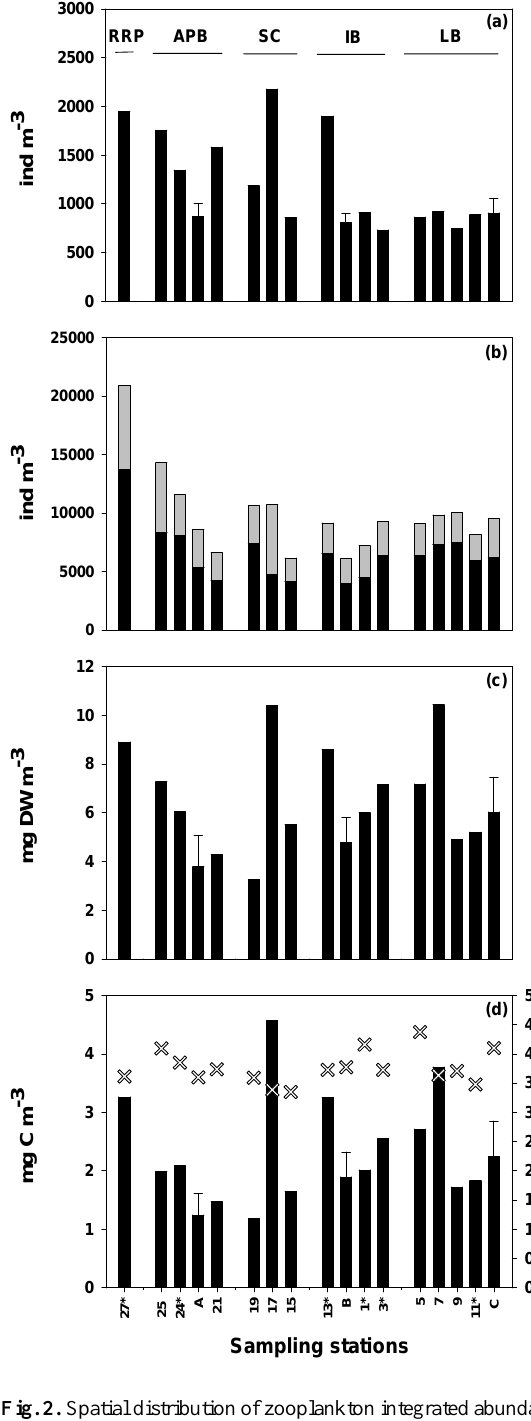
Fig. 2. Spatial distribution of zooplankton integrated abundance ob- tained by net sampling (a) and by Niskin bottle (b) including nauplii (black) and small copepods (grey), biomass as dry weight (c) and as carbon (d) with C/N ratio (cross). Mean and standard deviation for stations A, B and C. ( ∗ ) night sampling. See text for details on the five Mediterranean